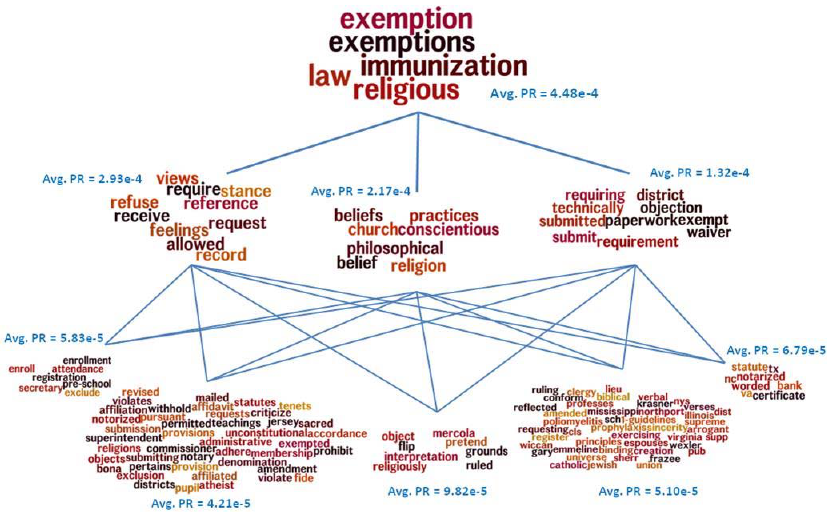
Figure 3. A visual representation of the “Vaccine Exemption” domain, identified from the numerous information and knowledge domains in two online parenting communities (Tangherlini et al. 2016).